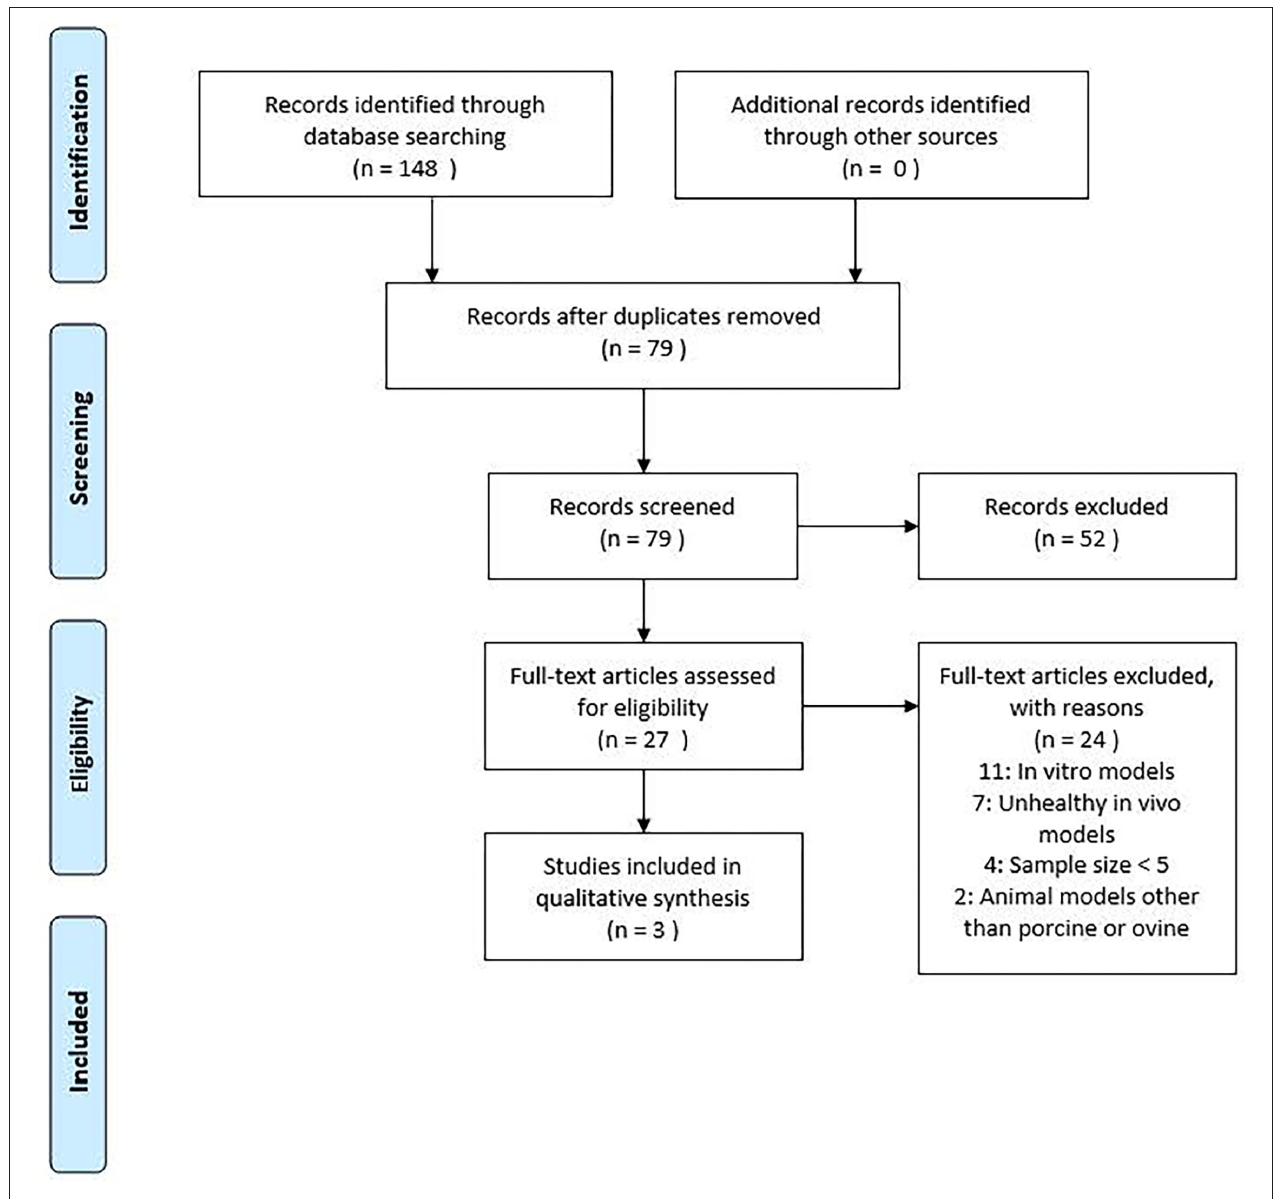
FIGURE 2 | PRISMA flow chart used for study selection.